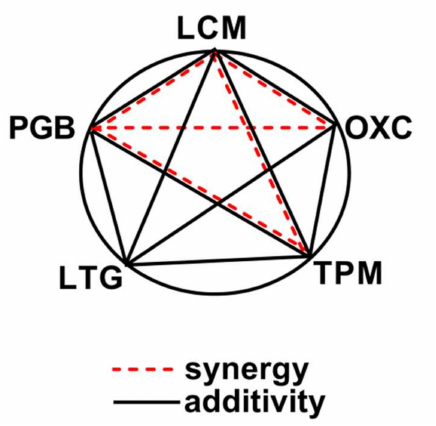
Figure 2. Polygonogram for triple ASM combinations.